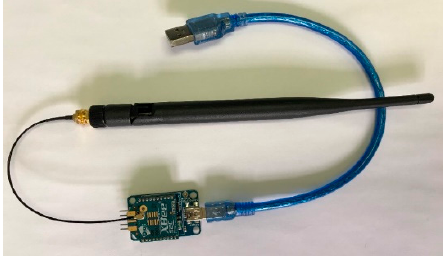
Figure 10. Receiver: Xbee card with antenna and USB cable.